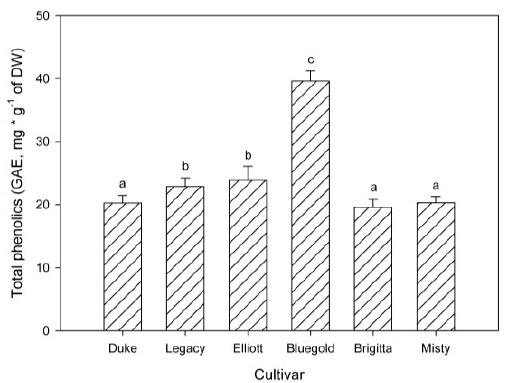
Figure 4. Total phenolic content of six in vitro highbush blueberry cultivars. Each bar corresponds at the mean of nine independent measurements ± standard error; letters represent significant differences ( p <